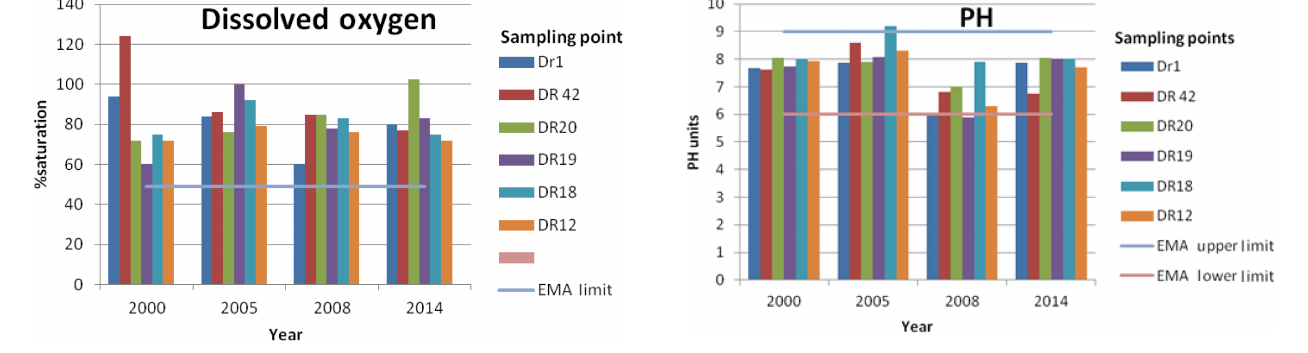
Figure 8. Dissolved Oxygen variation among sampling points.